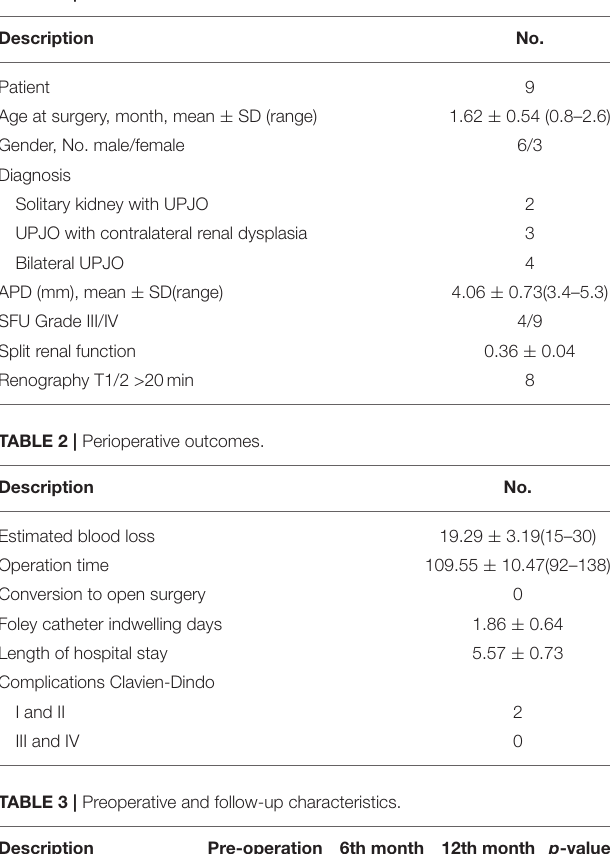
TABLE 1 | Patient characteristics.